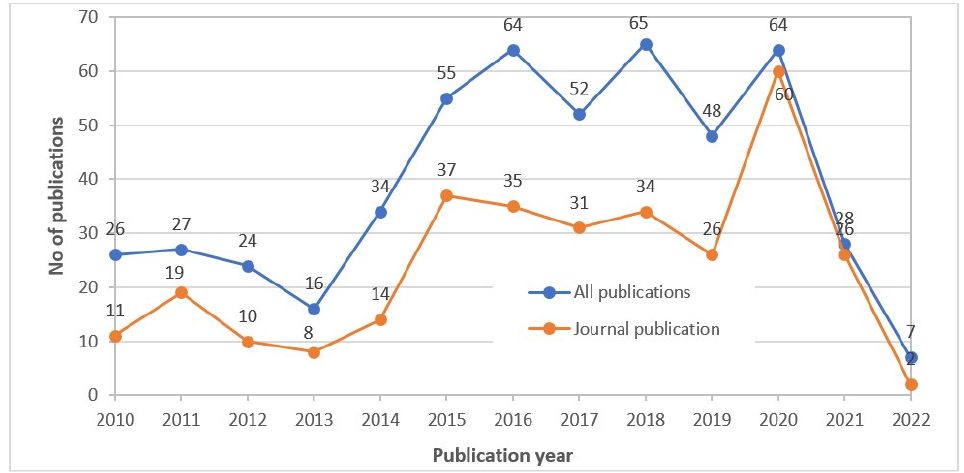
Figure 3. Yearly publications on TRC from 2010 to 2022 (up to 20th Feb).